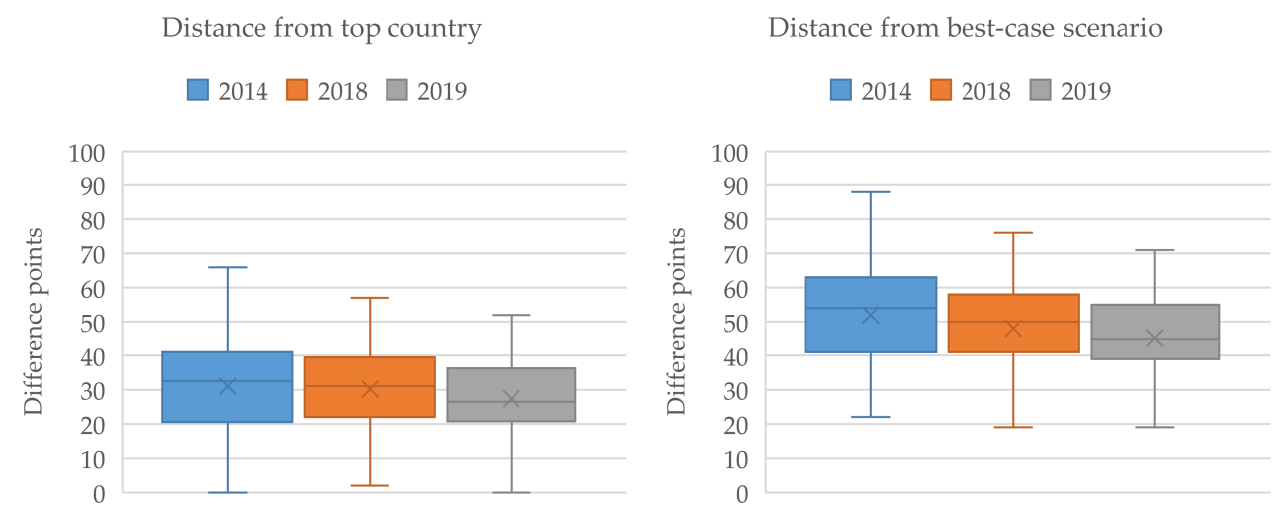
progress among considered countries. Starting from a score of 12, the closest any of the countries was to the worst- case scenario in any of the years, the country’s performance went up to 29 points in 2019. Figure 2. Distance from best-performing country of the year and best-case scenario. Source: authors’ computation . Figure 2 reflects the distance between the best-performing European country (left) -505101520 and the best-case scenario (right). Thus, an interesting and useful comparison can be made by referring to the country with the best performance and the best-case scenario.